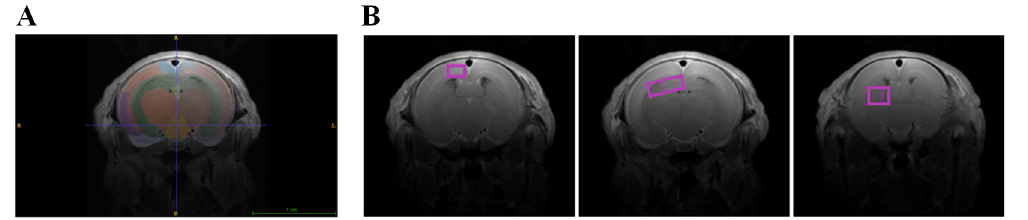
Fig 1. In vivo MRI with brain atlas registration and MRS voxel positions. (A) semi-automatic atlas registration on coronal T2-w image – legend: blue, cingulated cortex; orange and brown (outer), parietal cortex; purple, temporal cortex; grey, entorhinal cortex; red, subcortical white matter; green, hippocampus; orange and brown (inner), thalamus; yellow, corpus callosum; light orange, diencephalon. (B) MRS voxel positions on reference coronal T2-w MR images – from left to right: cortex, hippocampus, striatum.